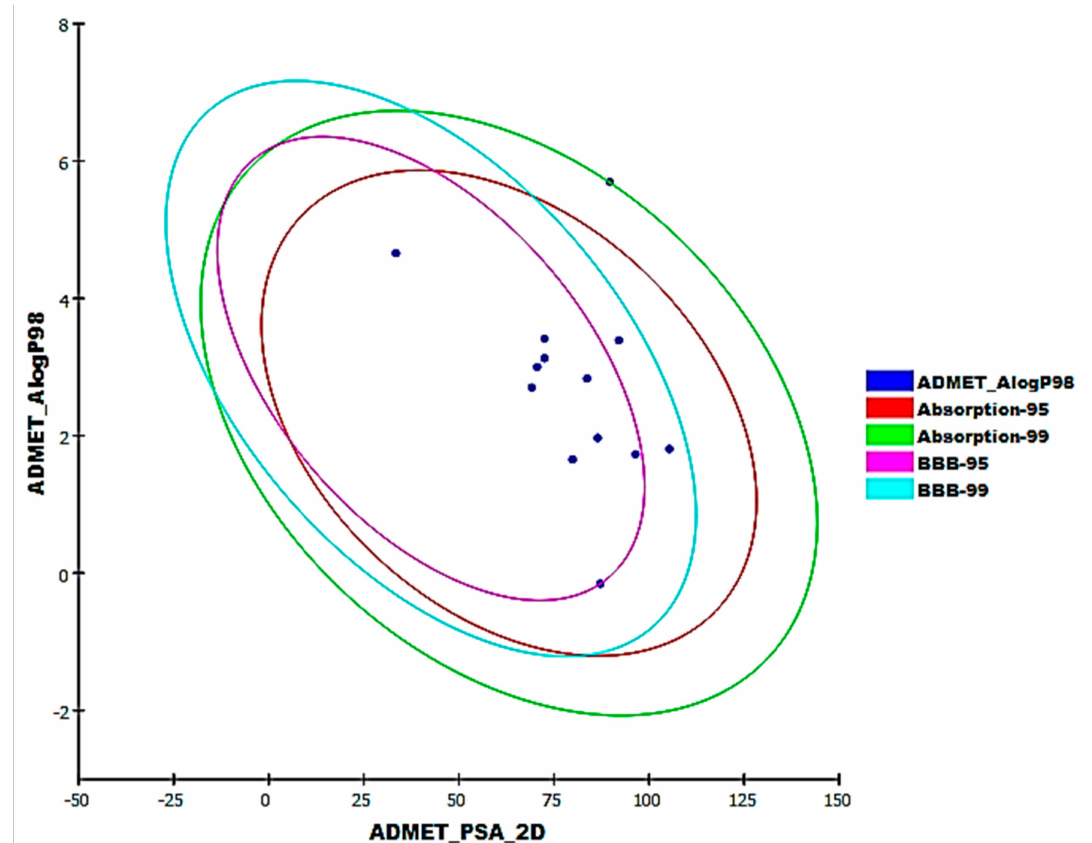
Figure 11. The expected ADMET study of the most potent semi-synthesized